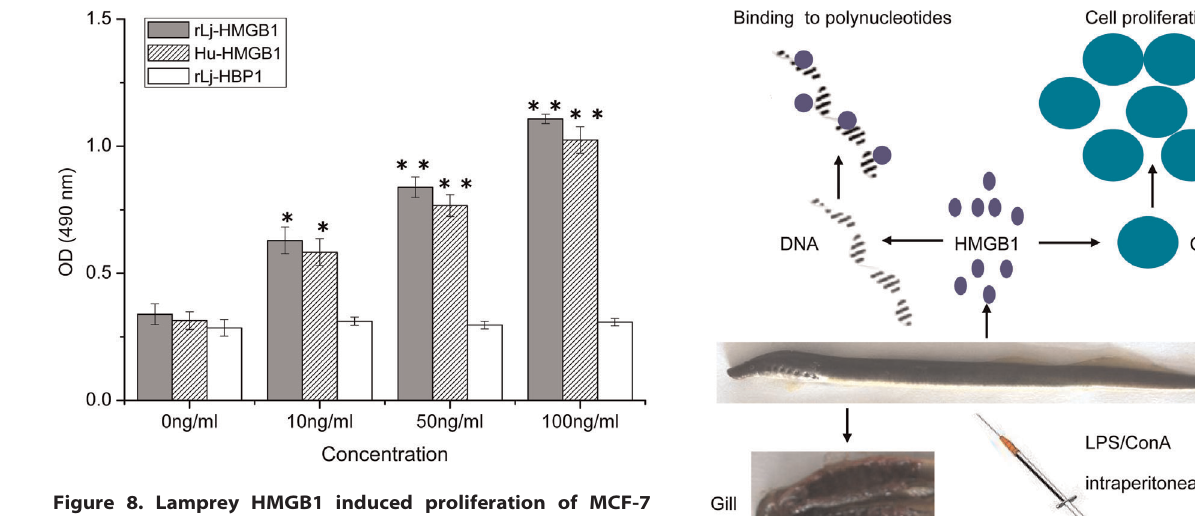
Figure 8. Lamprey HMGB1 induced proliferation of MCF-7 cells. MCF-7 cells were treated with different concentrations of rLj- HMGB1, Hu-HMGB1, or rLj-HBP1 for 24 h, and MTT assays were used to examine proliferation. Cells incubated with rLj-HBP1 were used as a negative control. ‘‘*’’ indicates a significant increase at p , 0.05, ‘‘**’’ indicates a significant increase at p , 0.01.